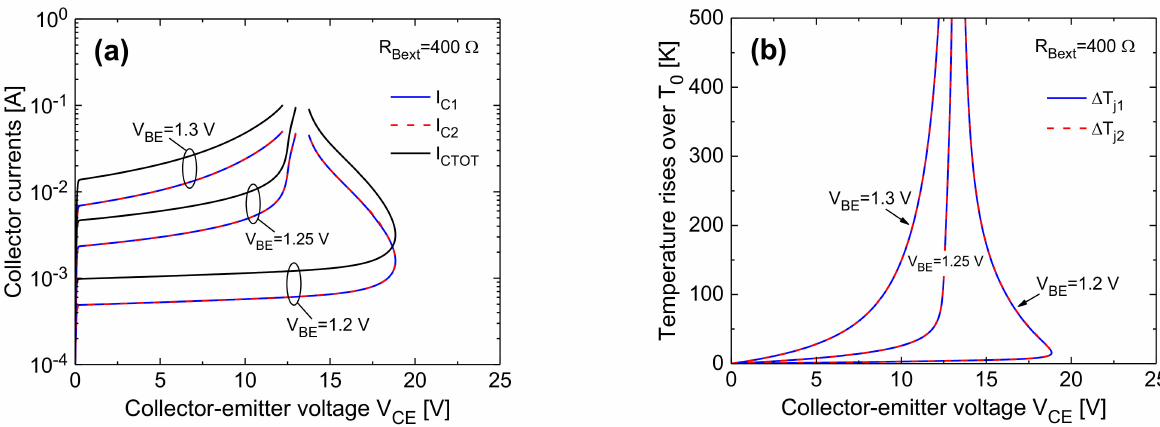
Figure 14. Ballasted (with R Bext = 400 Ω ) test device with two unit cells: simulated ( a ) collector currents and ( b ) junction temperature rises over T 0 vs. collector-emitter voltage V CE for V BE = 1.2, 1.25, 1.3